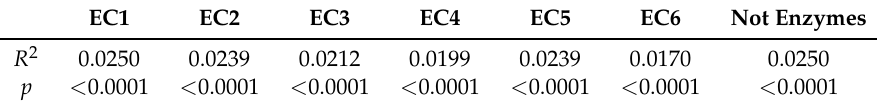
Table 5. Variance explained and statistical significance for the seven